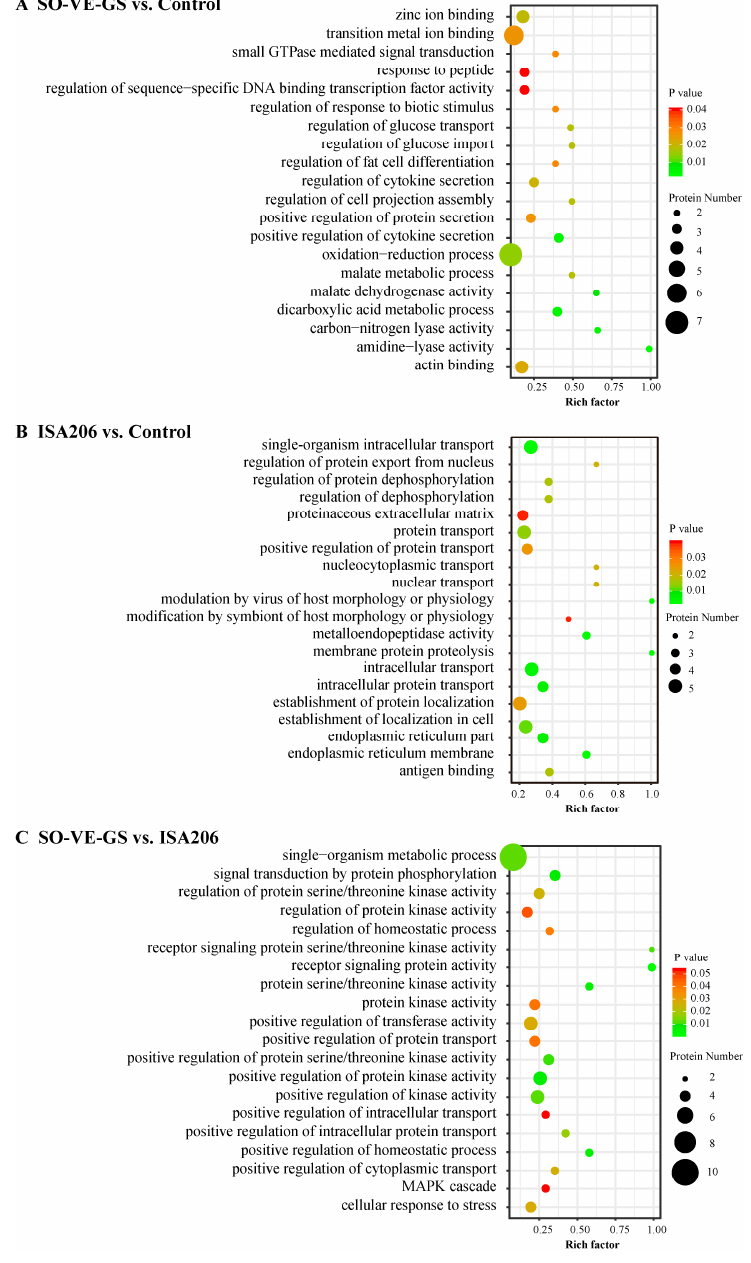
Figure 5. GO functional enrichment analysis. DEPs of ( A ) SO-VE-GS vs. control, ( B ) ISA 206 vs. control, and ( C ) SO-VE-GS vs. ISA 206 were used for GO functional enrichment analysis. The x-axis represents the value of the rich factor. The y-axis represents the enrichment of GO terms. The size of the dot represents the number of DEPs. The color represents corrected P value.